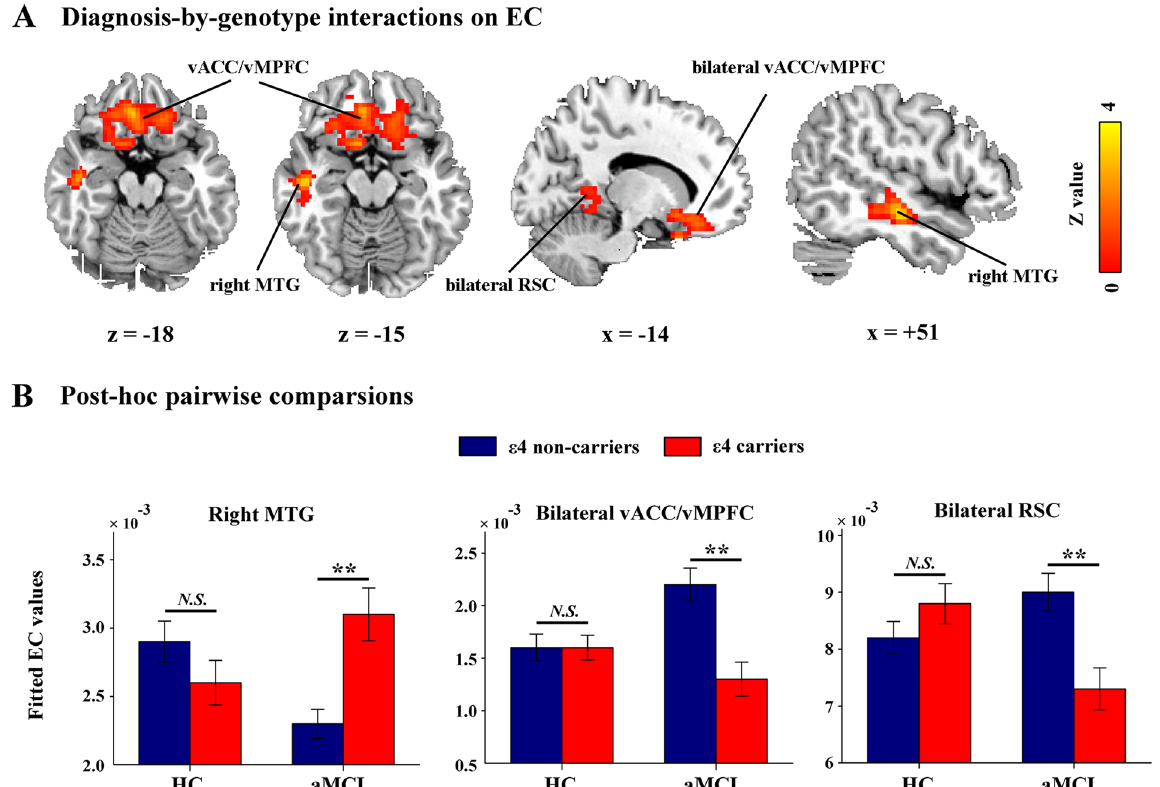
Figure 3. Diagnosis-by-genotype interactions on EC. ( A ) Two-way ANCOVA revealed significant diagnosis- by-genotype interactions on EC in the right middle temporal gyrus (MTG), bilateral ventral anterior cingulate/ ventral medial prefrontal cortex (vACC/vMPFC) and retrosplenial cortex (RSC). The color bar represents the statistical significance threshold ( Z -score). Multiple comparisons were conducted by a combined | z | > 1.96 ( P < 0.05) and cluster size > 4,266 mm 3 , which corresponded to a corrected P < 0.05. ( B ) The bar graphs depict post-hoc pairwise comparisons in the regions showing significant diagnosis-by-genotype interactions. The differences between the ε 4 carriers and non-carriers were significant in the aMCI group but not in the HC group. The data were expressed as the mean (M) ± standard error (SE). EC, eigenvector centrality; HC, healthy control; and aMCI, amnestic mild cognitive impairment. N.S. , Non-significant. ** P <